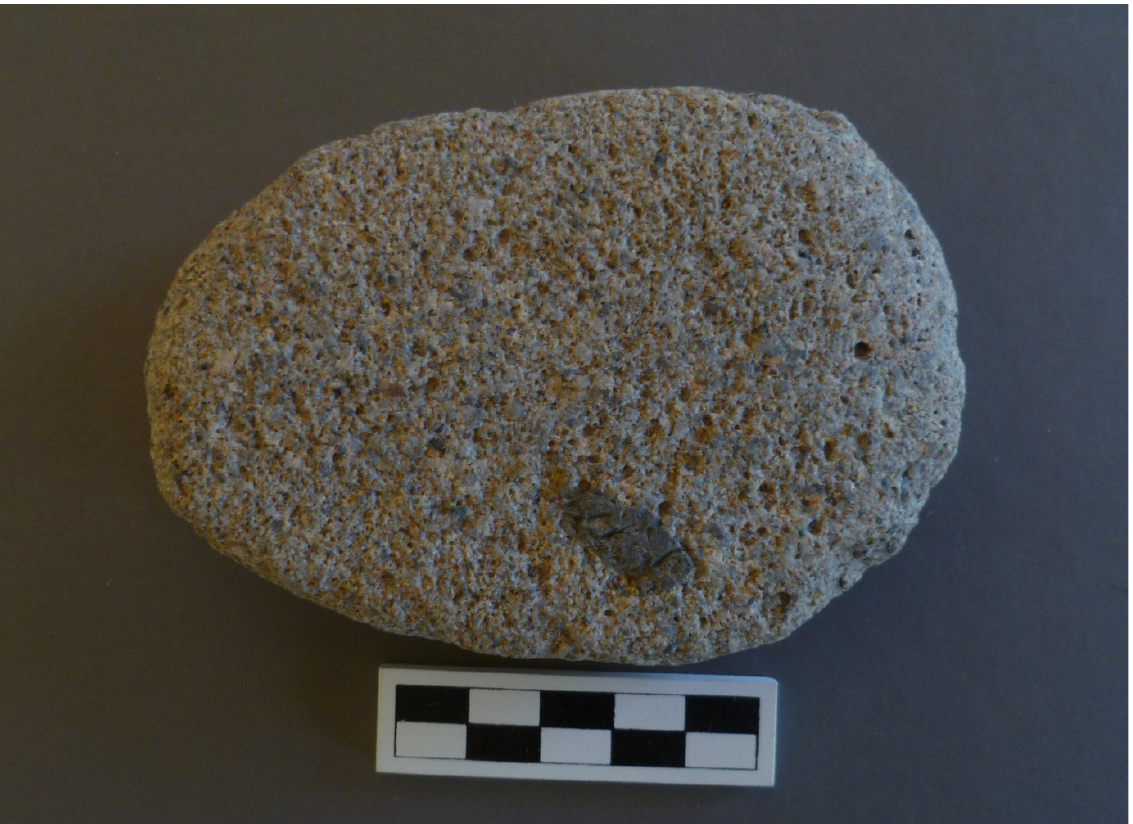
Figure 6. Typical sandstone hand stone from milling tool) from Burgasny Enger (Ikh-28). Plan view of working